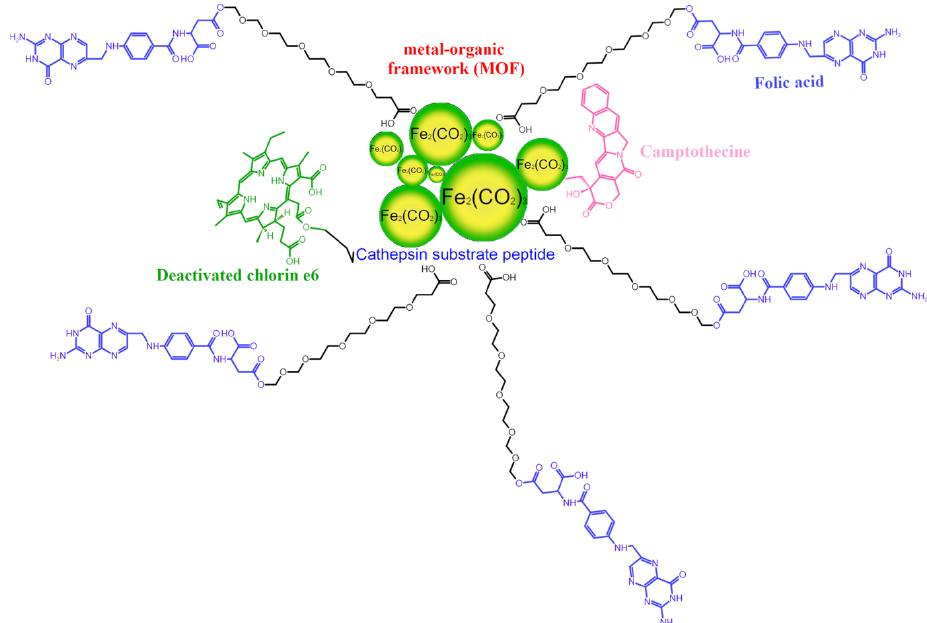
Figure 9. Chemical structure of the MOF nanoparticles bearing folic acid (blue), Ce6 (green), and camptothecin (pink) [65].